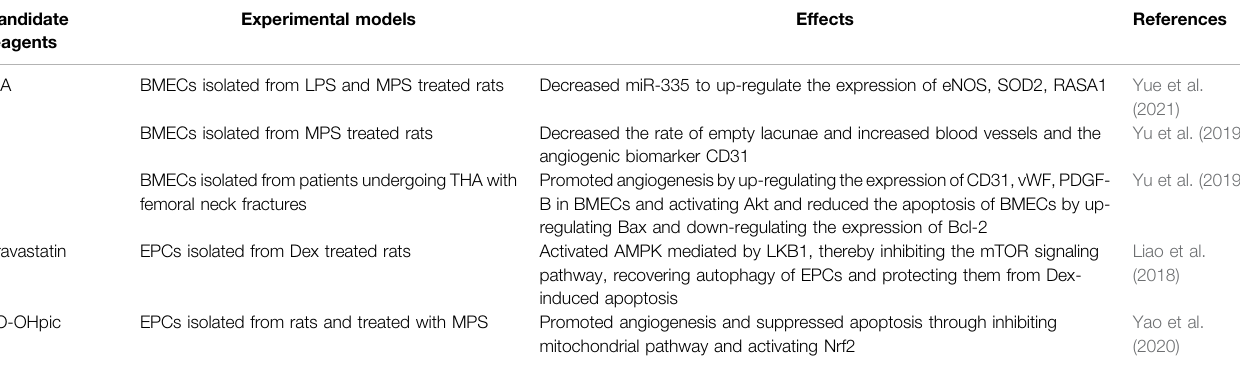
TABLE 1 | Candidate reagents targeting bone endothelial cells to treat SONFH.